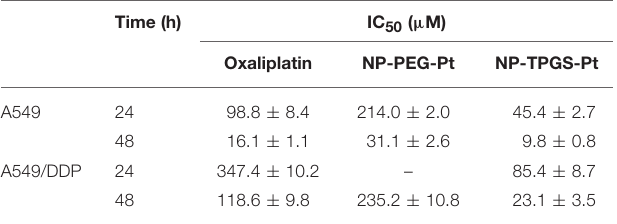
Oxaliplatin at 24 and 48 h were 347.4 and 118.6 µ M, respectively, TABLE 2 | IC 50 values of Oxaliplatin, NP-PEG-Pt and NP-TPGS-Pt against A549 and A549/DDP cells following 24 and 48h of